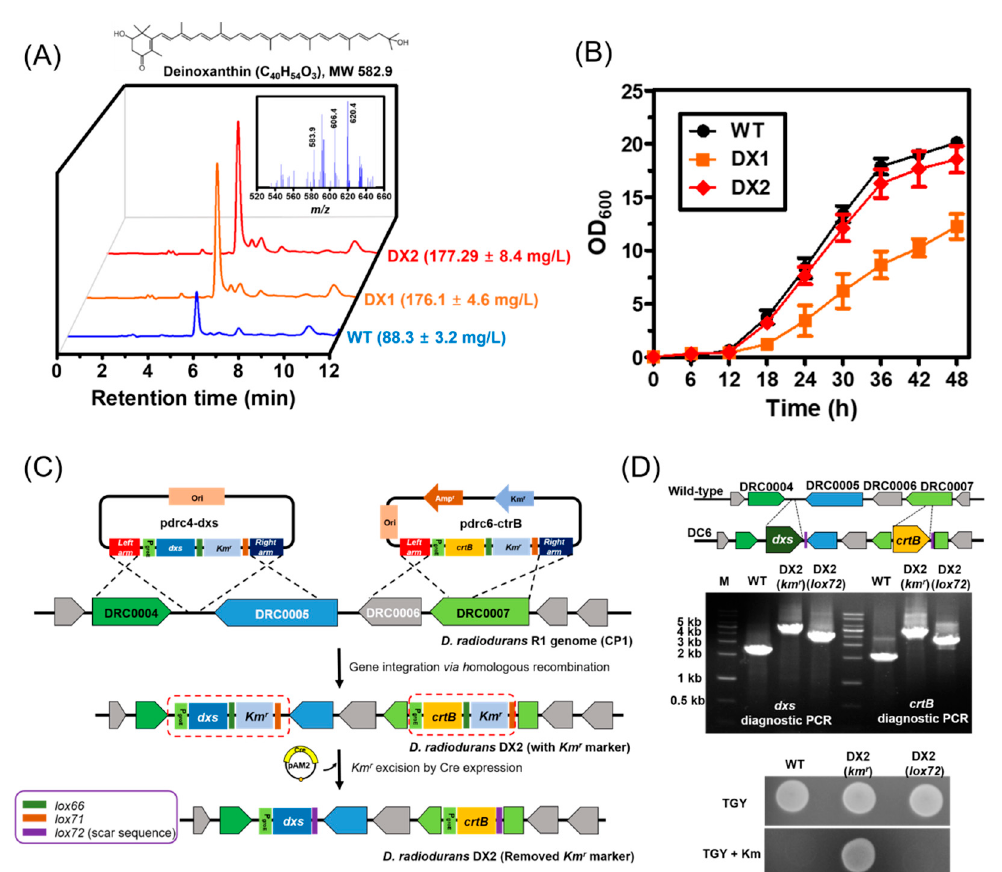
Figure 1. Cell growth and deinoxanthin production in engineered D. radiodurans strains. ( A ) Deinoxanthin production in the D. radidurans strains. HPLC spectra of the total carotenoids extracted from the D. radiodurans strains are presented. Inset presents the LC/MS spectra of total carotenoids obtained from the DX2 strain in positive ionization mode (ESI + ). The molecular ions at m/z 583.9, 606.4, and 620.4 were assigned to ([M + H] + ), ([M + Na] + ), and ([M + K] + ), which correspond to the presence of deinoxanthin. ( B ) Growth profiles of the plasmid-free D. radiodurans strain DX2 expressing the dxs and crtB genes over 48 h of cultivation. ( C ) Scheme of the construction of plasmid- and antibiotic-free D. radiodurans DX2 strain for deinoxanthin overproduction. The detailed procedure is described in the Materials and Method section. ( D ) Diagnostic PCR of dxs or crtB gene inserted in DX2 strain (upper panel). Plating assay of DX2 strain on trytone, glucose, and yeast (TGY) agar plate with or without kanamycin (25 μ g/mL) (bottom panel). The data represent the mean and standard deviation of biological triplicates.